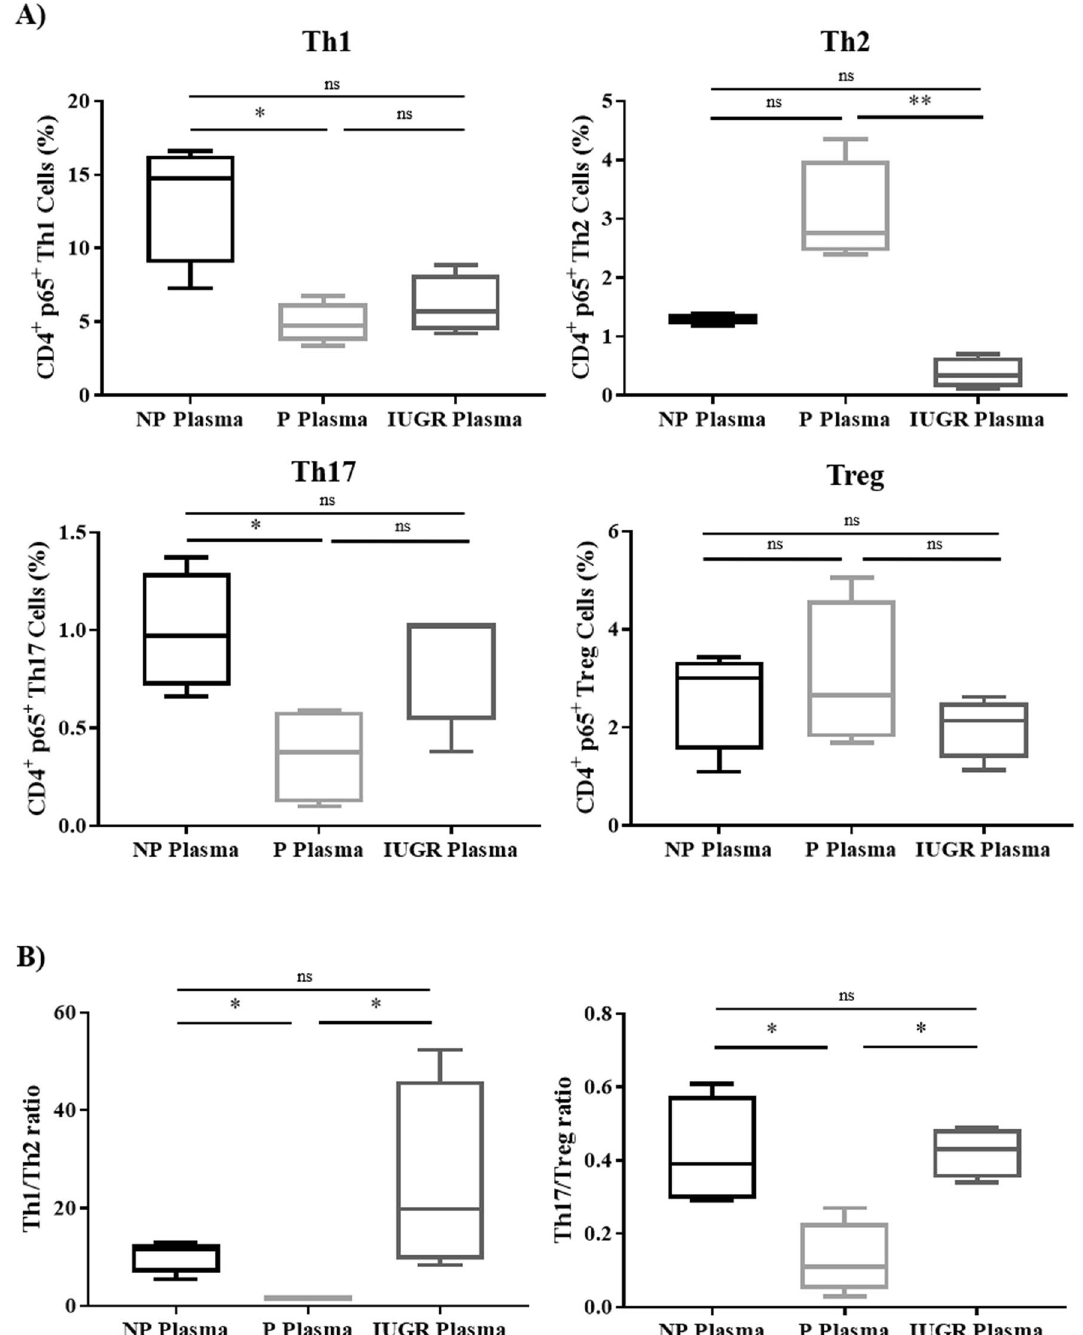
Figure 5. Expression of p65 in T-cell subsets is altered in the presence of healthy maternal plasma. Non- pregnant PBMCs were cultured in the presence of 20% NP, P or IUGR plasma (all n = 4). ( A ) Percentage of cells expressing p65 was determined by flow cytometry in CD4 + Th1, Th2, Th17 and Treg cells. ( B ) Percentage of cells expressing NF-κB p65 compared between pro- and anti-inflammatory cell types as a ratio between Th1 and Th2, or Th17 and Treg. Box and whisker plots indicate median and IQR of cells expressing p65. * p < 0.05, ** p < 0.01, ns = non-significant, determined by Kruskal–Wallis with Dunn’s multiple comparisons test. Flow cytometry data were analysed using the FlowJo Software Version 10 (Becton Dickinson); website: https:// www. flowjo.